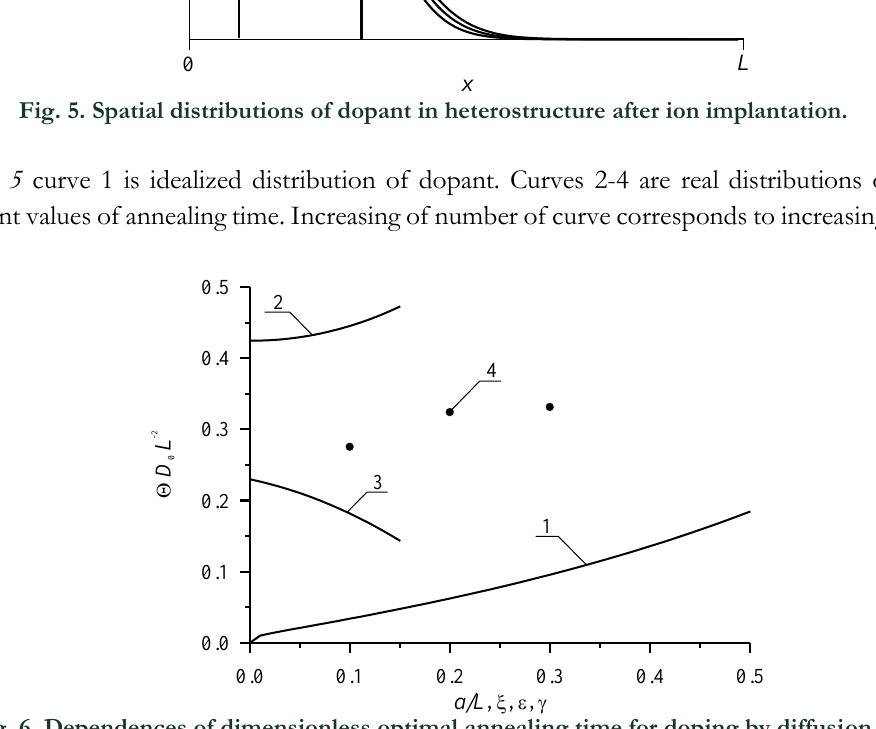
Fig. 6. Dependences of dimensionless optimal annealing time for doping by diffusion, which have been obtained by minimization of mean-squared error, on several parameters.